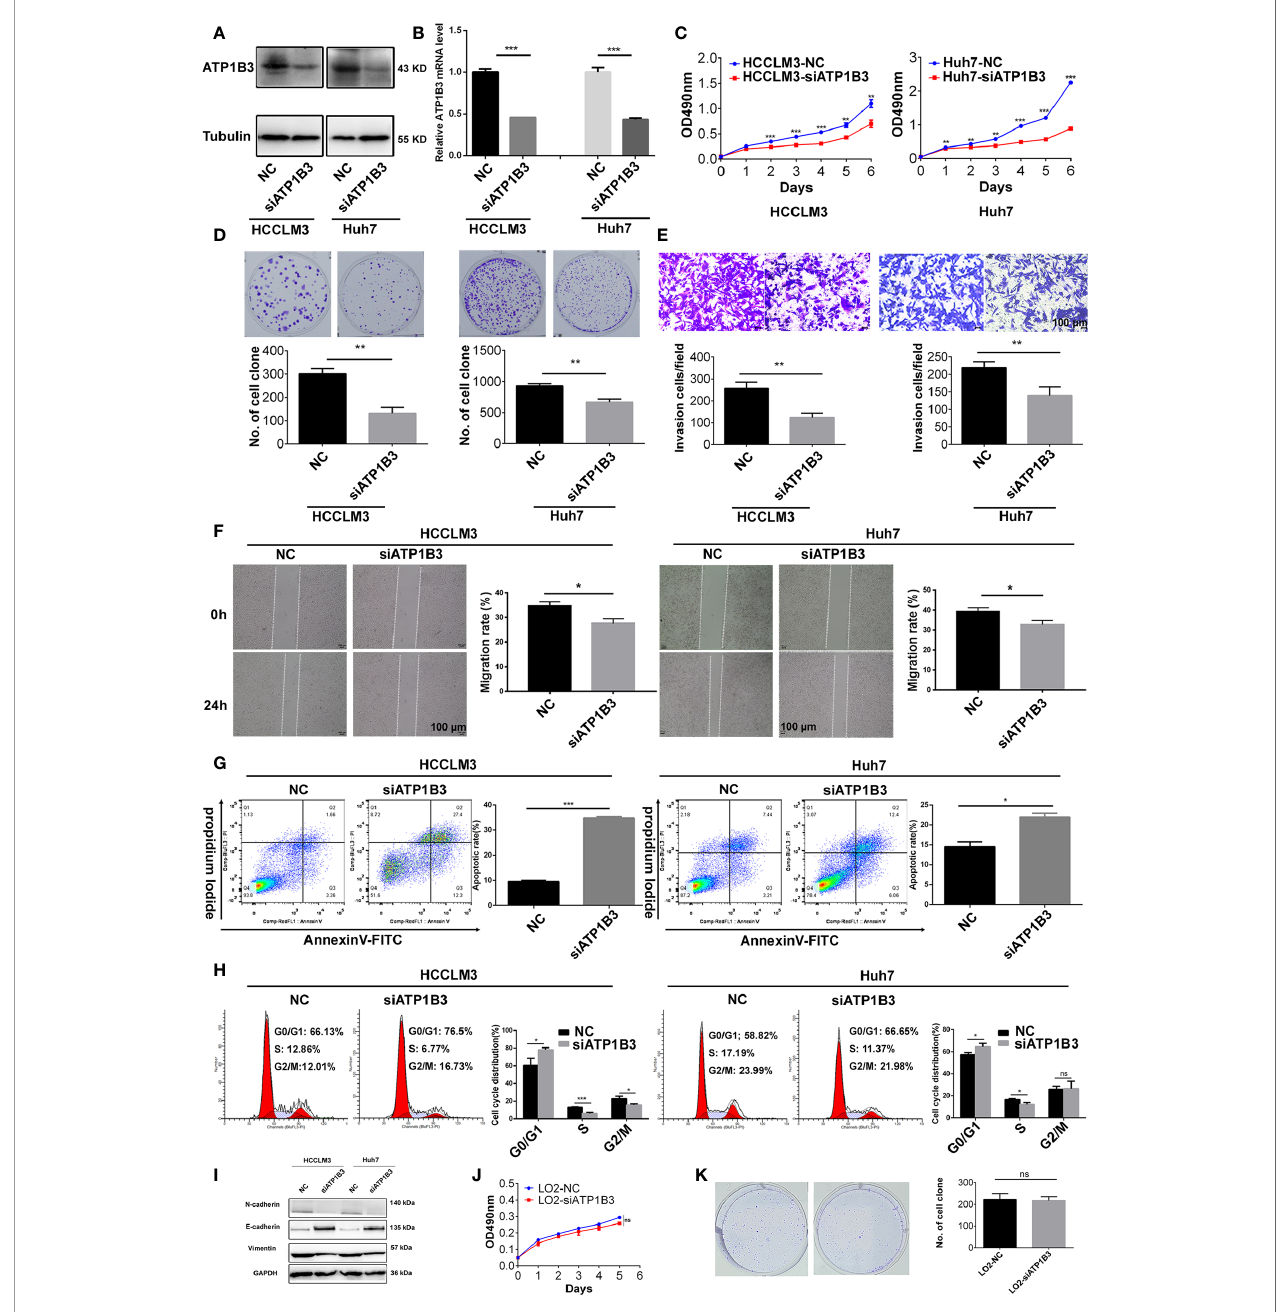
FIGURE 10 | ATP1B3 promotes HCC cell proliferation, migration and inhibits HCC cell apoptosis. Western Blot (A) and qPCR (B) showed that the expression of ATP1B3 were silenced by siRNA in Hhu7 and HCCLM3, respectively. MTT (C) and plate clone formation (D) analysis revealed the cell proliferation regulated by ATP1B3. Transwell migration (E) and scratch wound healing (F) assay revealed the migration ability regulated by ATP1B3. Apoptosis (G) and Cell cycle (H) assay revealed the regulation of ATP1B3 on cell apoptosis and cell cycle using fl ow cytometry. (I) The EMT markers in ATP1B3 silenced HCC cells. The effects of ATP1B3 on cell proliferation in LO2 by MTT (J) and plate clone formation (K) . Scale bars= 100 m m, * p < 0.05, ** p < 0.01, *** p <